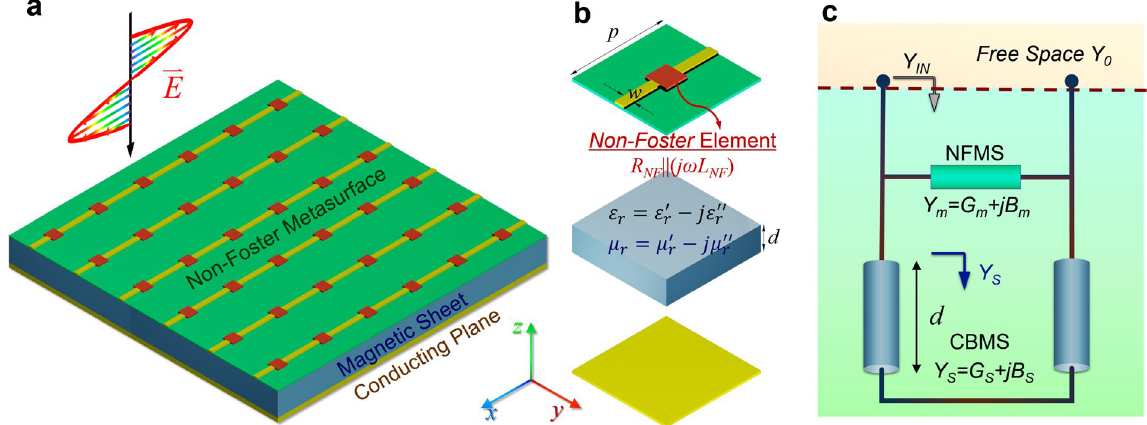
Figure 1. Configuration and design concept of the proposed NFMS magnetic absorber. ( a ) Conceptual structure of the NFMS magnetic absorber. It is a two-dimensional infinite periodic structure and only 6 × 6 unit cells are demonstrated. ( b ) Expanded view of the unit cell with each layer separated. The non-Foster element is an active circuit in practical, and can be represented by a lumped device due to its electrically-small footprint. ( c ) Transmission line model of the NFMS magnetic absorber based on microwave transmission line theory. Y 0 is the free-space admittance, and Y IN is the input admittance of the absorber at the interface between the free space and